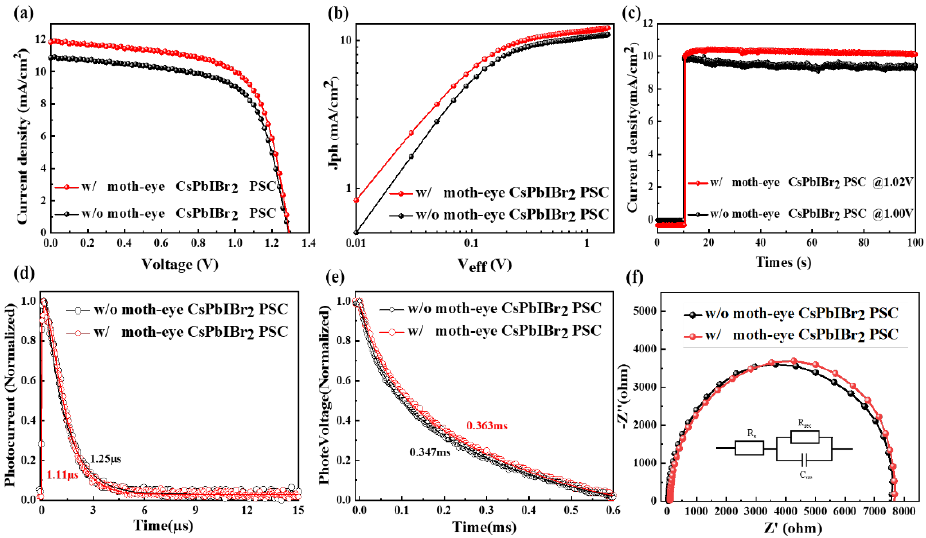
Figure 2. ( a ) J-V curves, ( b ) J ph -V eff curves, ( c ) stable output characteristic curves, ( d ) TPC characteristic curves, ( e ) TPV characteristic curves, and ( f ) Nyquist curves with and without moth-eye structure device.